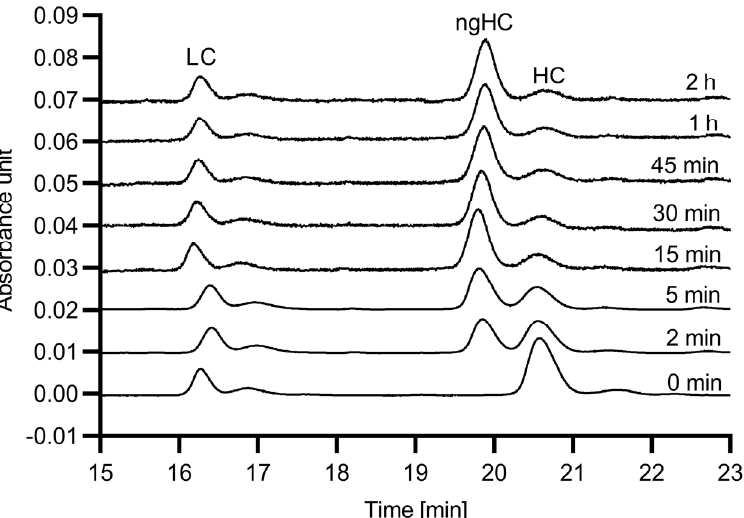
Figure 1. SDS-CGE analysis of the hIgG1 sample with different 6His-PNGase F digestion times at 37 ◦ C . Peaks: LC: light chain, ngHC: non glycosylated heavy chain, HC: heavy chain. Conditions: 30 cm total (20 cm effective) length, 50 µ m ID bare fused silica capillary with SDS-MW gel buffer. Applied electric potential: 15 kV (reverse polarity mode); temperature: 25 ◦ C; injection: 5 kV/20 s.